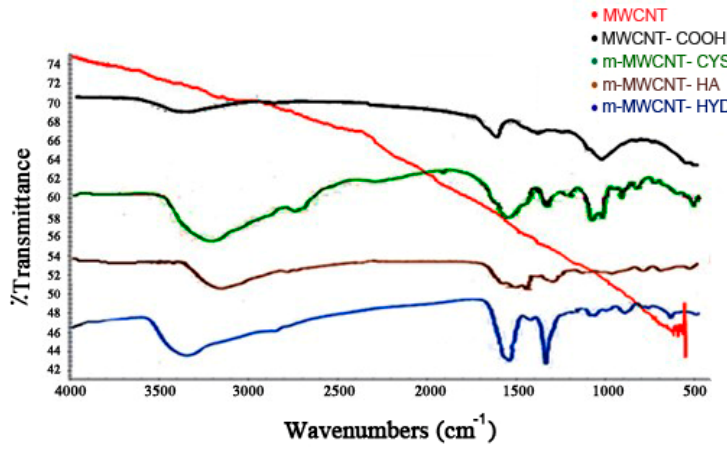
Figure 4. FT-IR spectra for MWCNT, MWCNT–COOH, m-MWCNT–HA, m-MWCNT–CYS, and m- MWCNT–HYD.